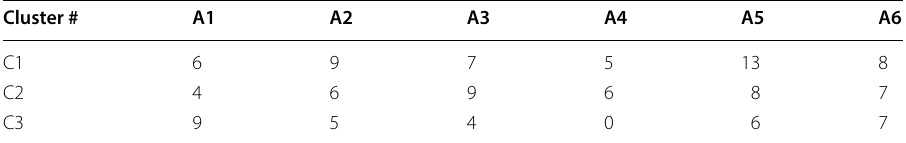
Table 17 Net Access Cost Cluster Matrix